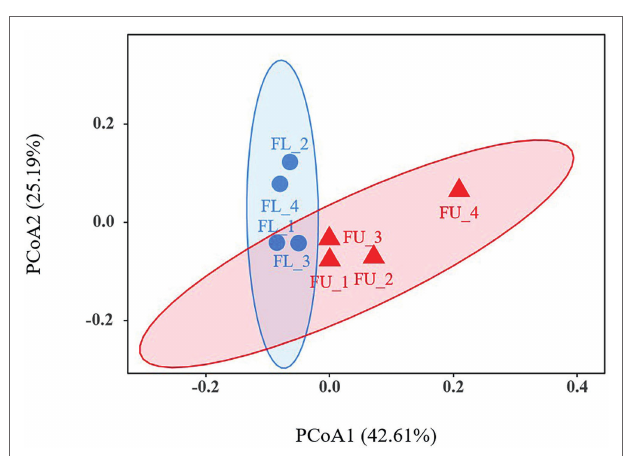
FIGURE 5 | Principal co-ordinates analysis (PCoA) at operational taxonomic unit (OTU) level. The red triangles represent FU soil samples, and the blue circles represent FL soil